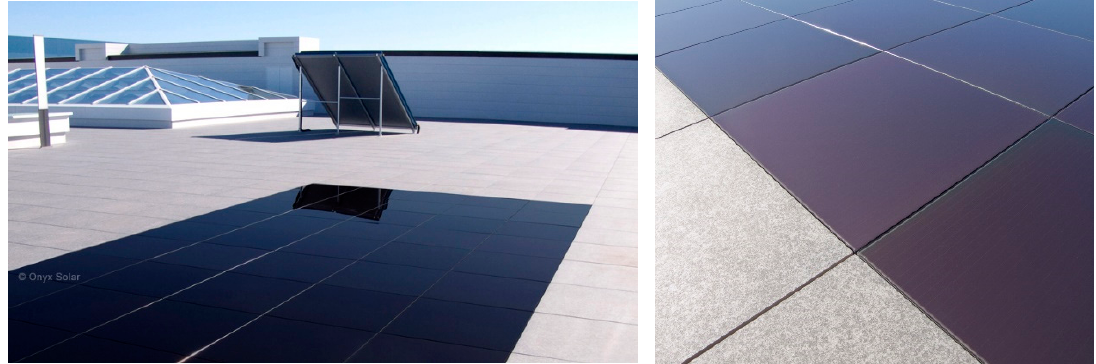
Figure 5. Walkable photovoltaics solution for the flat roof (source: Onyx Solar).